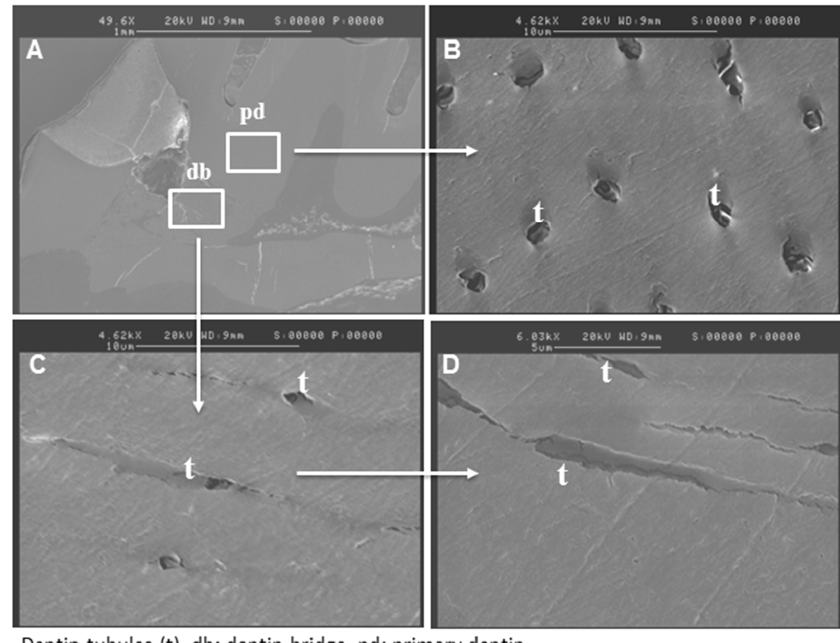
Figure 2. Scanning electron micrograph after direct pulp capping using Biodentine ™ . SEM analysis shows well-mineralized tissue near the pulp exposure ( A ) and at higher magnification, many dentinal tubules through the reparative dentin bridge can be observed ( C , D ). The number of dentinal tubules is lower than that of the primary dentin ( B ). Materials 2019 , 12 , x FOR PEER REVIEW